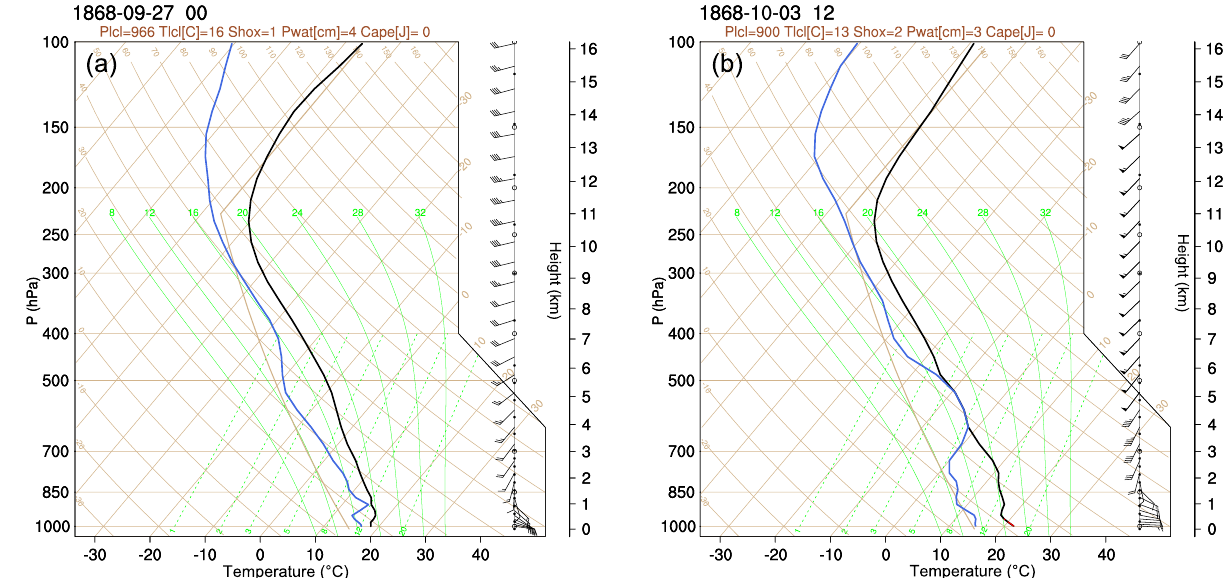
Figure 10. Simulated sounding from WRF model output at Milano Linate Airport (LIML; see Fig. 11b for location) for (a) 27 Septem- ber 1868 12:00UTC and (b) 3 October 1868